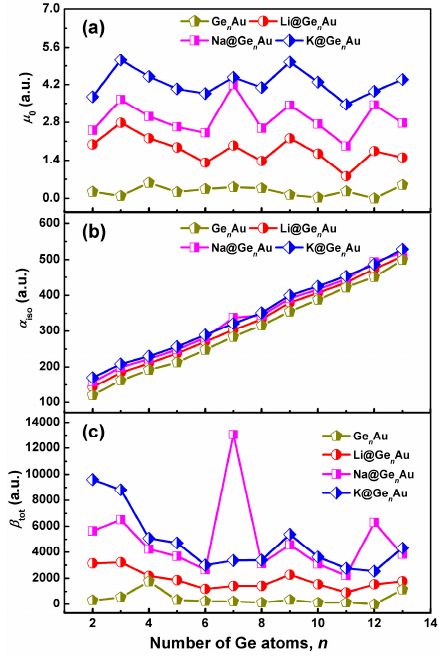
Figure 6. Comparison of evaluated ( a ) dipole moments ( µ 0 ), ( b ) isotropic polarizabilities ( α iso ), and ( c ) static first hyperpolarizability ( β tot ) of AM@Ge n Au (AM = Li, Na, and K; n = 2–13) with Ge n Au cluster, calculated at the CAM-B3LYP/def2-TZVPD level of